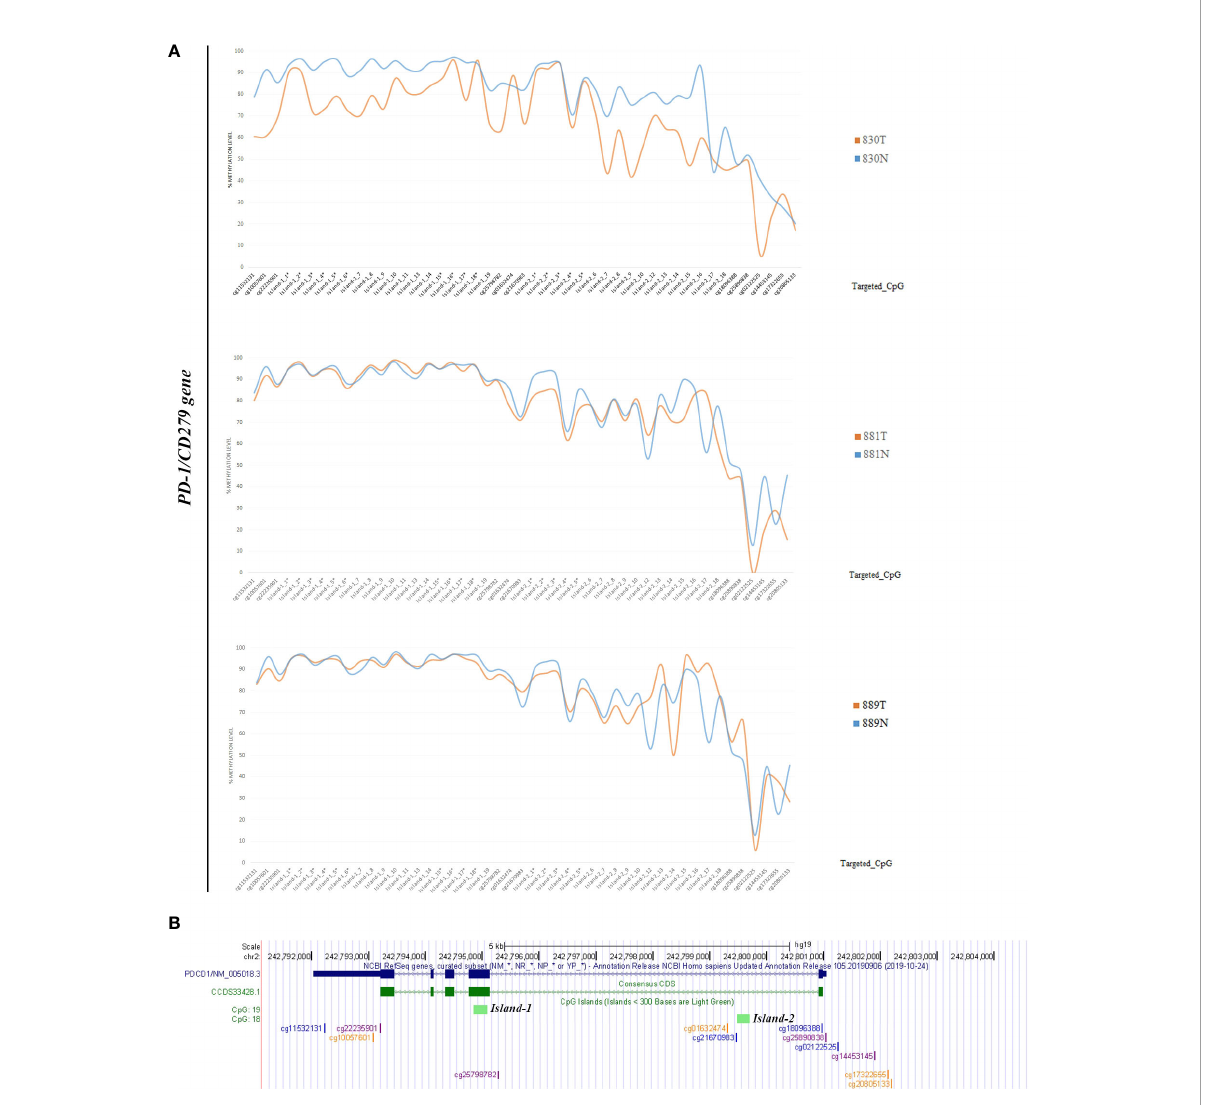
FIGURE 3 (A) Schematic epigrams showing the CpGs methylation levels along different PD-1/CD279 gene regions in paired tumor/normal FFPE samples. (B) Schematic representation of the PD-1/CD279 gene structure within the human hg19 genome sequence. From top to bottom: NCBI RefSeq and Consensus CDS tracks for PD-1/CD279 exon/intron structure; predicted CpG islands ( “ Regulation ” >> “ CpG Island ” track); CpG methylation sites map targeted by OPERA_MET-A panel are